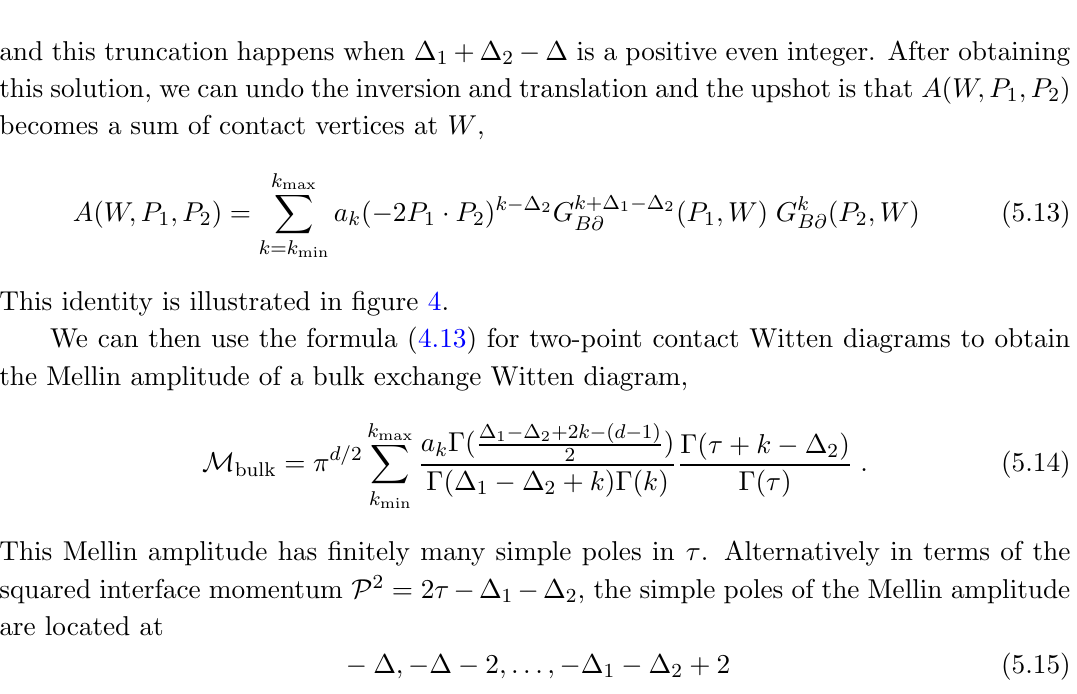
Figure 4 . A bulk exchange Witten diagram is replaced by a sum of contact Witten diagrams when (cid:1) 1 + (cid:1) 2 (cid:0) (cid:1) is a positive even